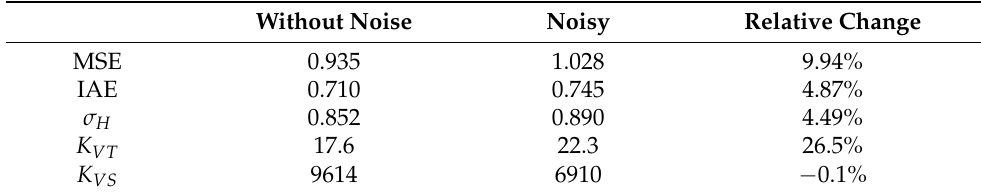
The transfer function G 2 ( s ) loop is simulated using varying control error filter time constant values from T F = 0 s up to T F = 1.0 s incremented every 0.01 s. The filter